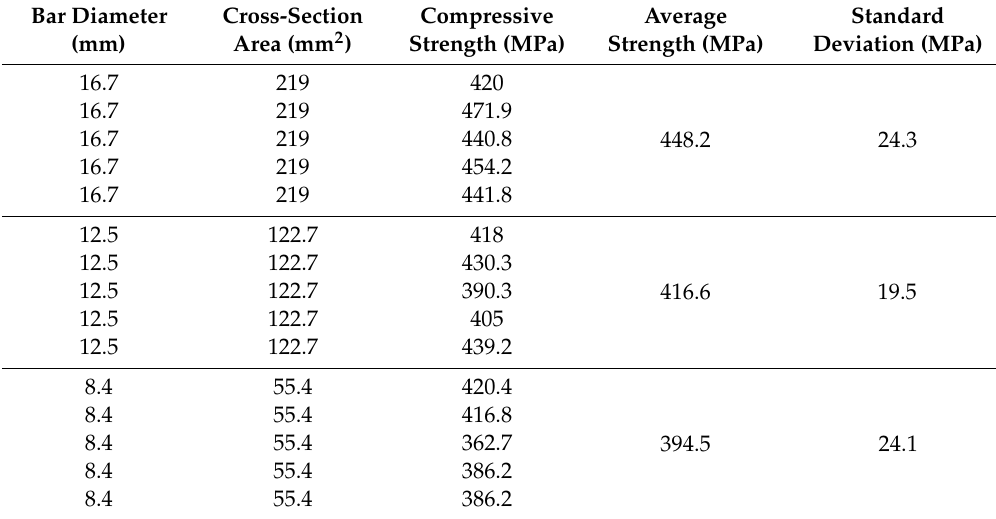
Table 3. Properties of the BFRP reinforcements.